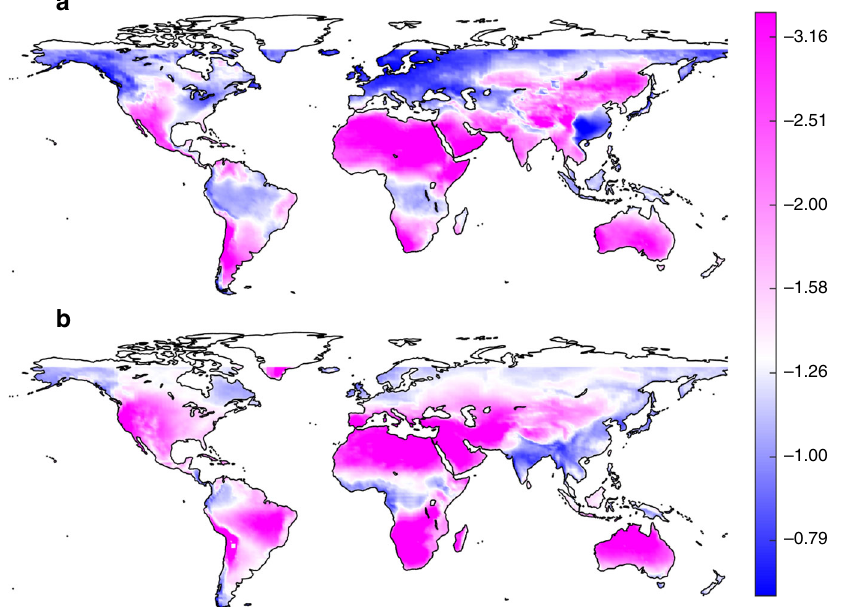
Fig. 5 Global maps of LOLP sensitivity ( L s ). This sensitivity in ( a ) January and ( b ) July is obtained from analytical solutions with design LOLP of 0.3 and solar radiation climatology from CERES. Source data are provided as a Source Data fi